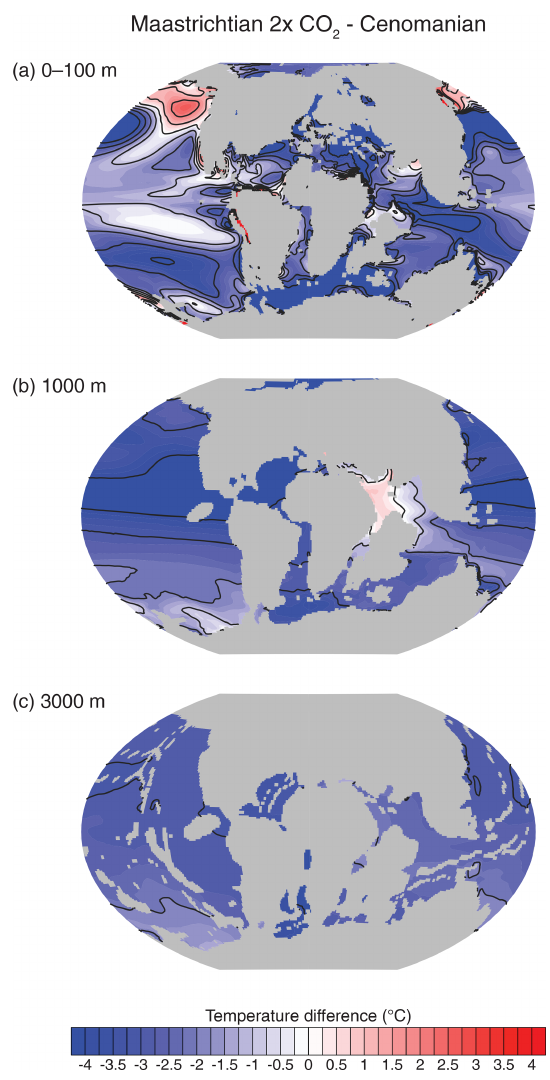
Figure 16. Surface, intermediate and deep ocean temperature dif- ference ( ◦ C) between the 2 × CO 2 Maastrichtian and Cenomanian